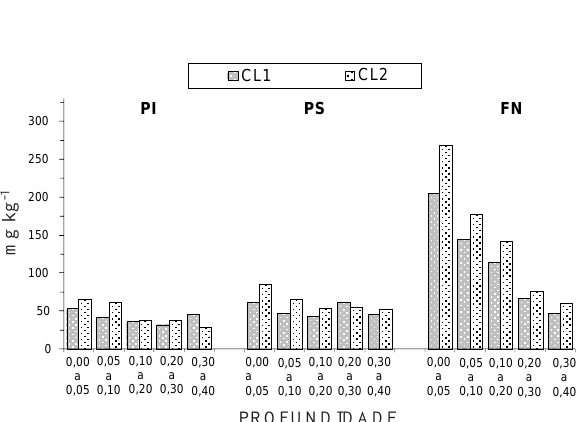
Figura 2. Carbono mineralizável nos agregados maiores e menores que 0,25 mm, respectiva- mente (CM1 e CM2), de solos sob plantio direto irrigado (PI), plantio direto de sequeiro (PS) e floresta nativa (FN), em cinco